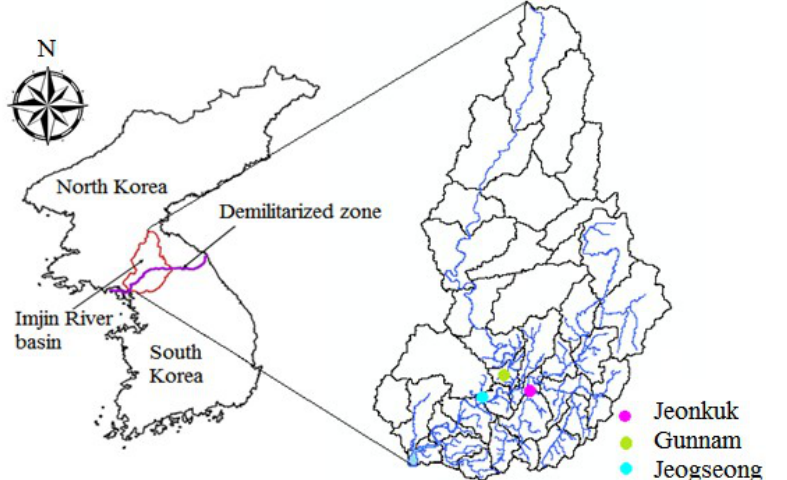
Figure 1. Location, sub-basins, river network and water level gauging stations of the Imjin River basin.